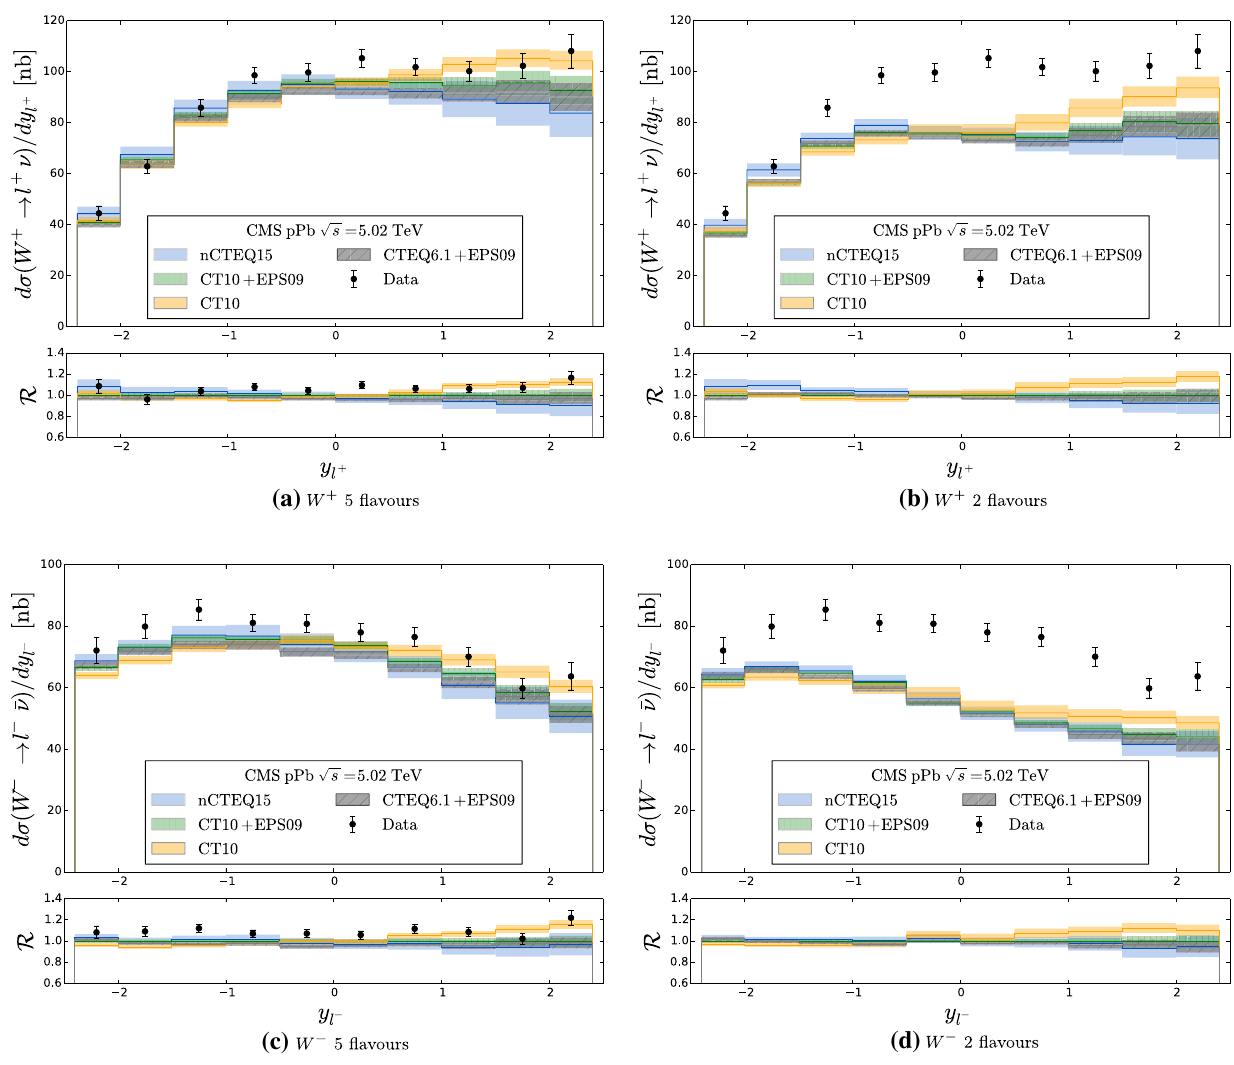
Fig. 15 Rapidity distributions for W ± cross sections measured by CMS compared with predictions from the nCTEQ15 , EPS09+CT10, EPS09+CTEQ6.1 and CT10 PDFs. Figures a and c show the results for five flavors, while Figs. b and d show the two flavors